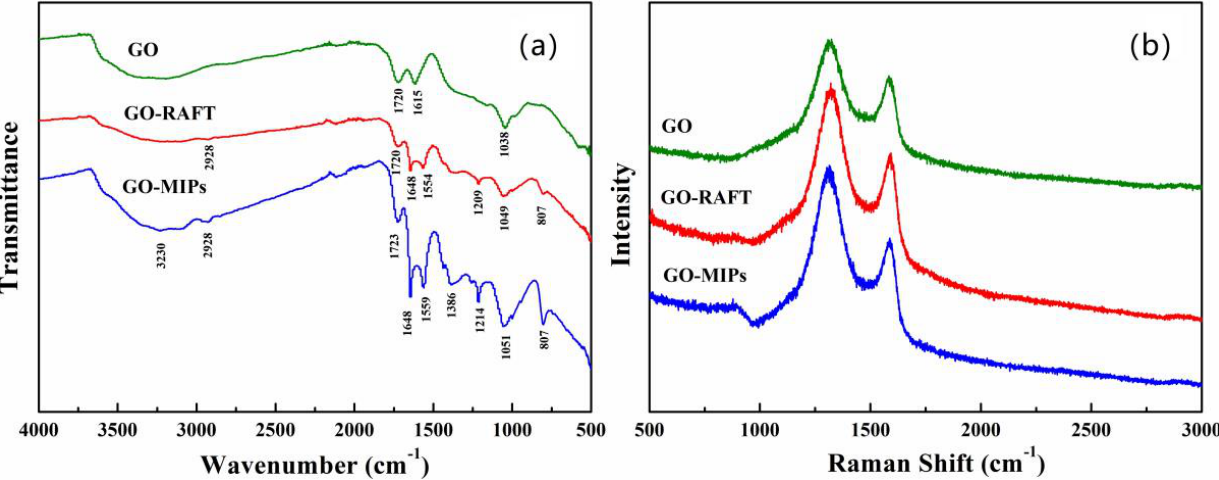
Figure 1. FTIR spectra ( a ) and Raman spectra ( b ) of GO, GO-RAFT, and GO-MIPs.